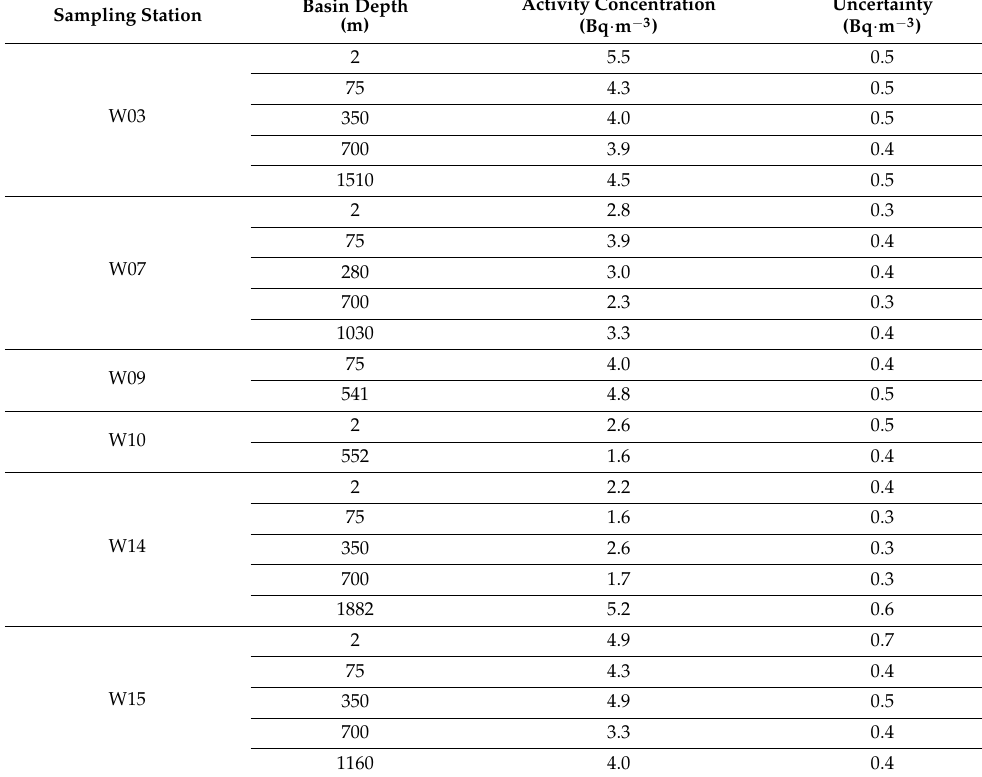
Table 2. The measured data of 137 Cs activity